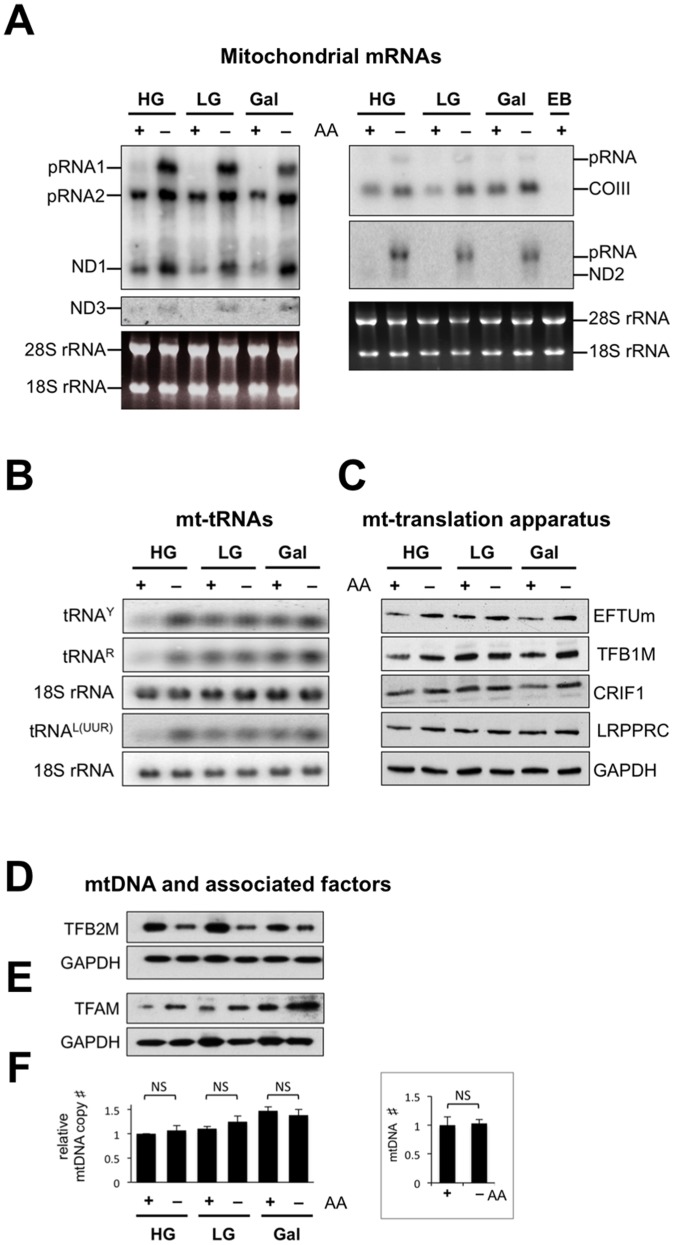
Amino acid deprivation increases the levels of several mitochondrial RNAs, their protein products, and TFAM and EFTu.DNA, RNA, and protein were harvested from HEK cells grown for 72(A) and (B) Northern hybridization with probes corresponding to mRNAs and tRNAs, respectively. COIII, cytochrome oxidase III mRNA; ND1-3, RNAs encoding subunits of complex I; pRNA, precursor RNA; EB, ethidium bromide. 18S and 28S rRNA are the RNA elements of cytosolic ribosomes. R – arginine, Y – tryptophan, L(UUR) – Leucine. (C) Immunoblots of selected mitochondrial translation machinery factors: EFTUm – mitochondrial translation elongation factor; TFB1M, modifies the RNA of the small subunit of the mitochondrial ribosome; CRIF1, a contributor to normal mitochondrial translation; LRPPRC, a mitochondrial mRNA-interacting protein. (D) and (E) Immunoblots of TFAM and TFB2M, respectively. (F) Q-PCR estimation of mtDNA copy number; n = 6; error bars represent the s.e.m. There was no significant change in mtDNA copy number as a result of amino acid withdrawal based on the unpaired student’s t-test, NS not significant (p>0.05), for any sugar concentration, or all (inset). Using the same test there was a significant increase in the mtDNA copy number when glucose was replaced by galactose (Figure S6).